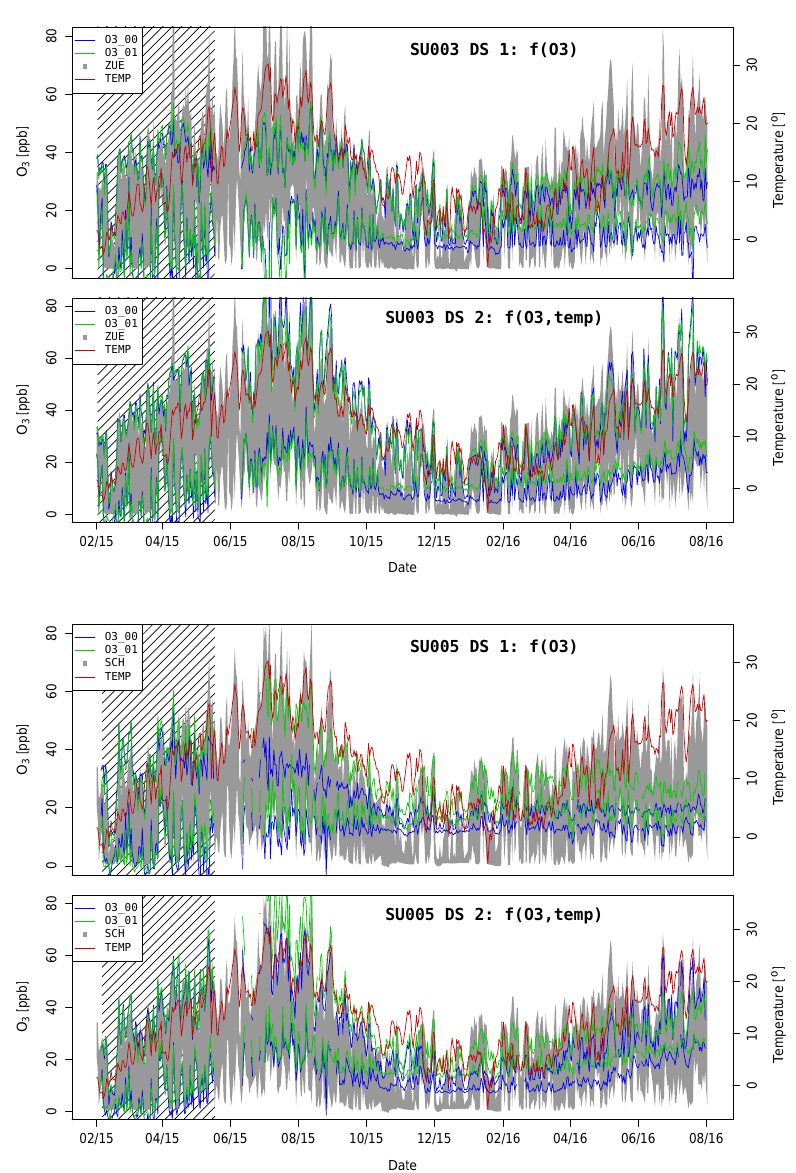
Figure 5. Daily range of 30min mean O 3 concentrations indicated by the two sensors O3_00 and O3_01 integrated in the SUs 003 and 005. It is depicted by two lines representing the daily maximum and minimum (DS 1: basic linear model; DS 2: advanced model based on Eq. (5) including temperature as a parameter; see Table 4 for details). The grey band depicts the same value for the AQM site where the sensor unit was located for calibration. This AQM site is also comparable with the location where the SU was operated within the sensor network with respect to the pollutant situation. The time period in which the sensors were calibrated at the AQM site is depicted by a shaded area (calibration PAR). Temperature is the daily mean value at AQM site